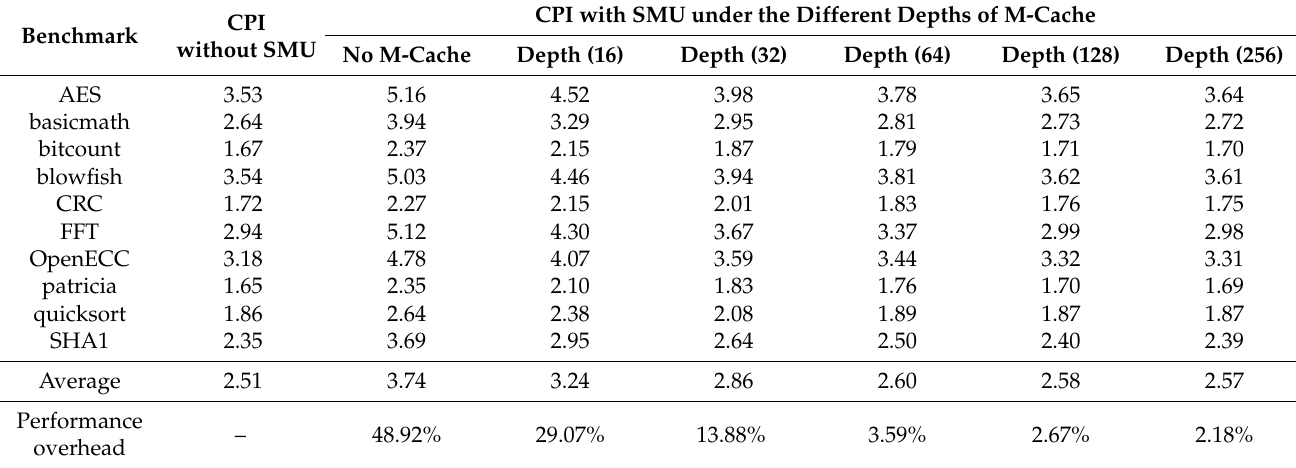
Table 2. Performance overhead of a processor configured with different depths of the monitor cache.